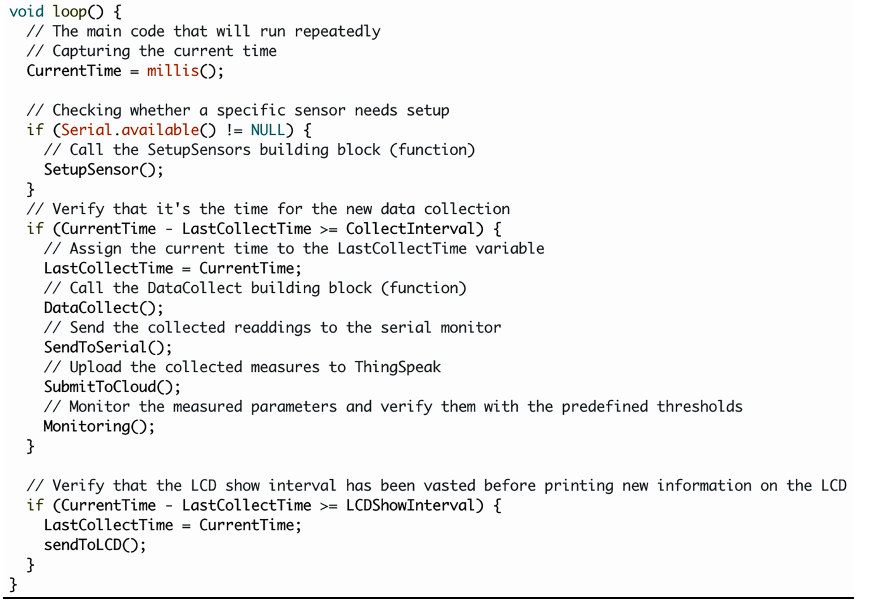
Figure 5. The main code to be repeated in our